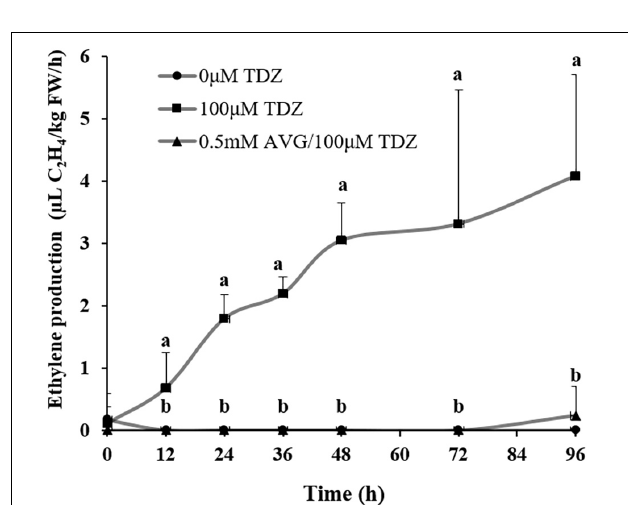
FIGURE 6 | The effect of TDZ on the time course of ethylene production in shoots from control and AVG pretreated miniature rose plants. Means ( ± SE, n = 6) within days with different letters are significantly different at P ≤